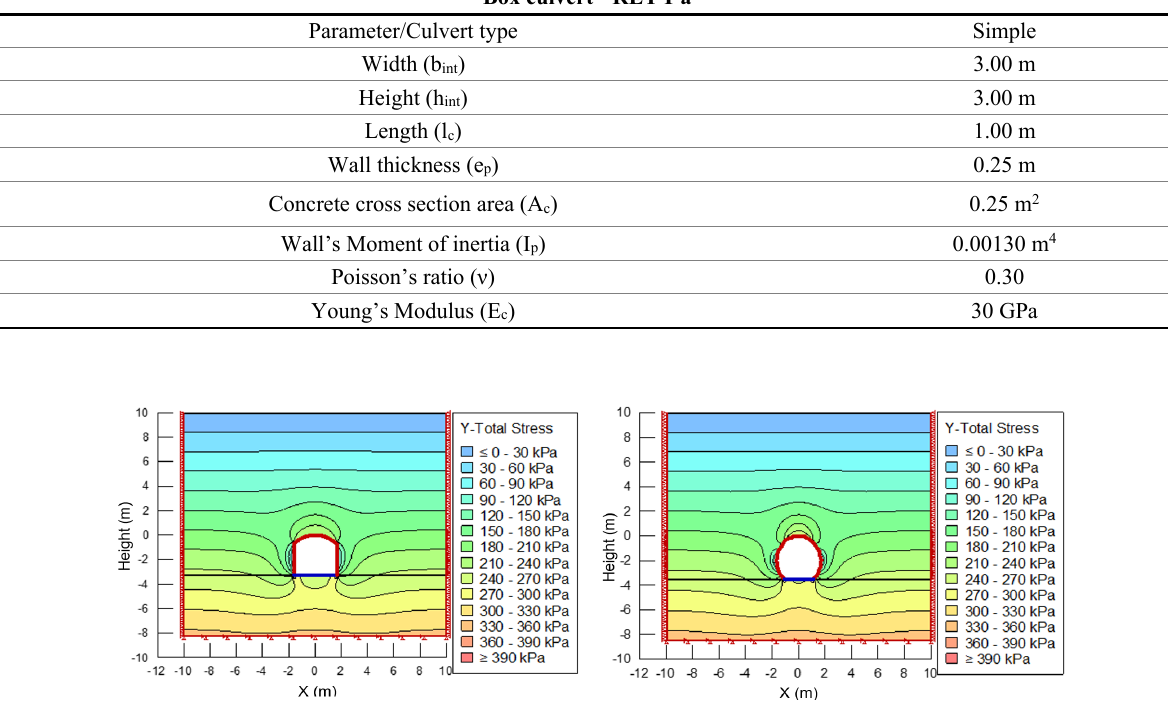
Figure 7. Vertical pressure distributions.